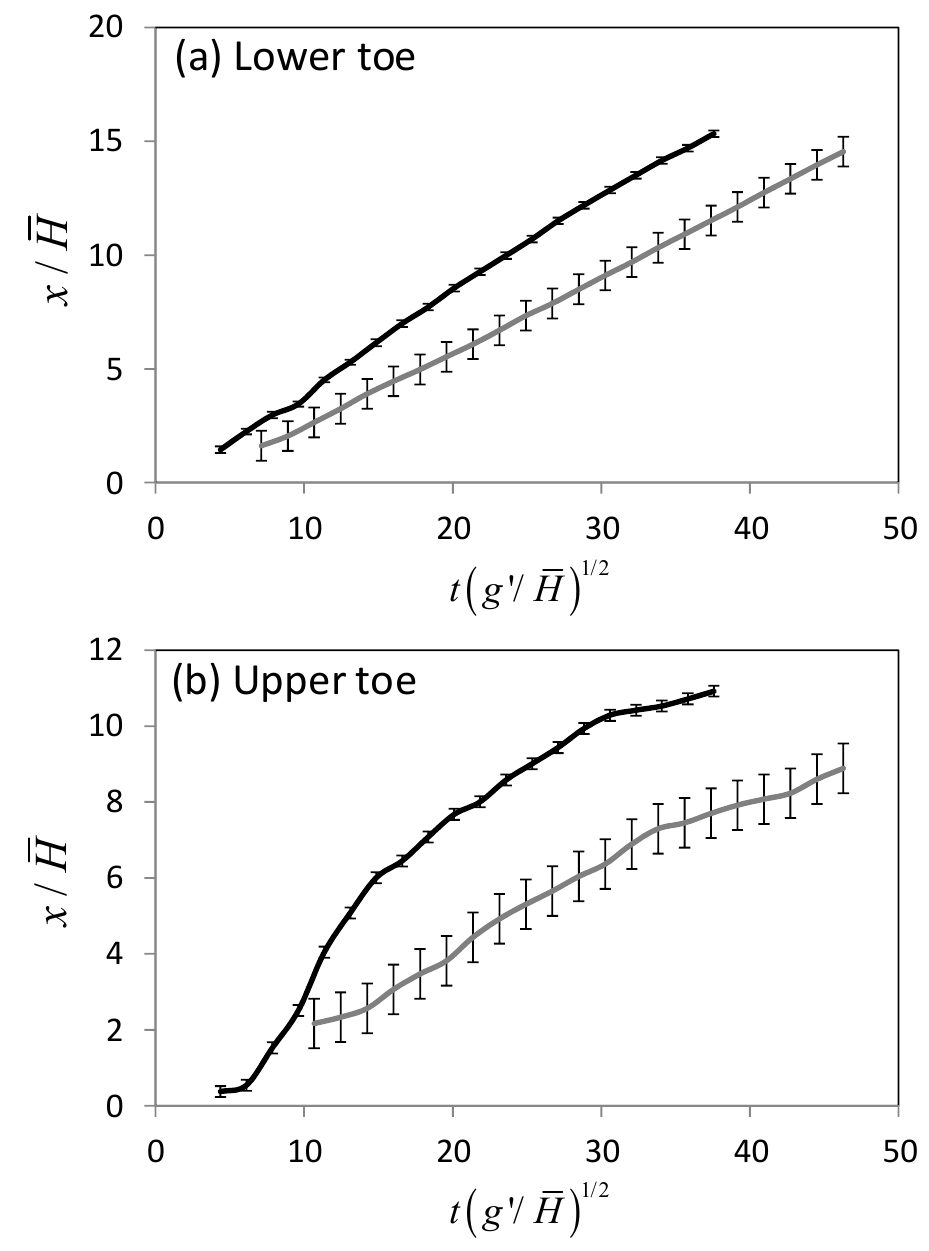
Figure 6. Temporal evolution of the lower and upper current toe positions at a slope of 0.075 (~4.3 ◦ ) and g (cid:48) = 2.1 cm/s 2 : ( a ) lower toe and ( b ) upper toe. Note: “ ”: 6.9% model canopy distributed in deep regions (Run 8), and “ ”: 6.9% model canopy distributed in shallows (Run 6).